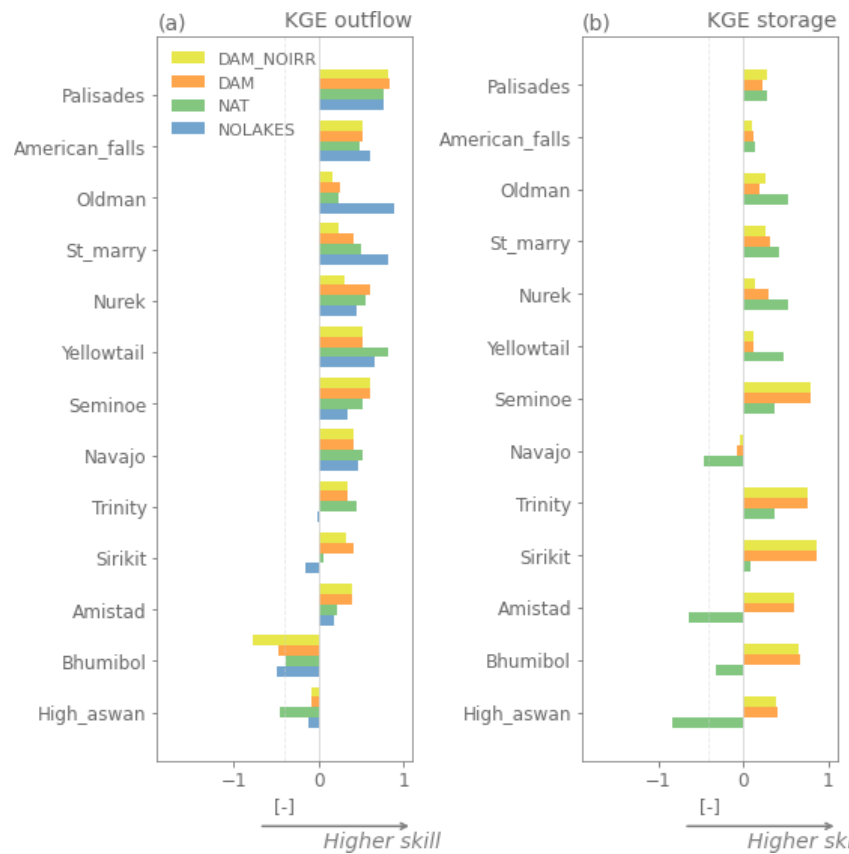
Figure A1. Evaluation with Kling–Gupta efficiency (KGE) for irrigation reservoirs of the Hanasaki et al. (2006, DAM) and Döll et al. (2003, NAT) parameterizations with observed inflows and run-of-the-river conditions (assuming there is no lake; NOLAKE) against observed outflow (a) and observed storage (b) using observations from Yassin et al. (2019). The reservoirs are ordered from low to high capacity ratio.